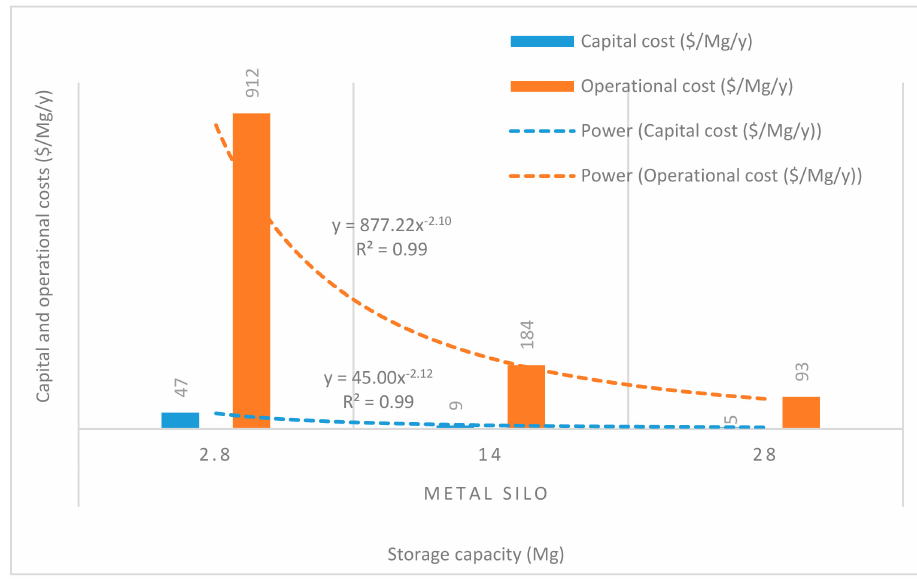
Figure 8. Economies of scale of capital and operational costs ($ / Mg / y) of using metal silo only.